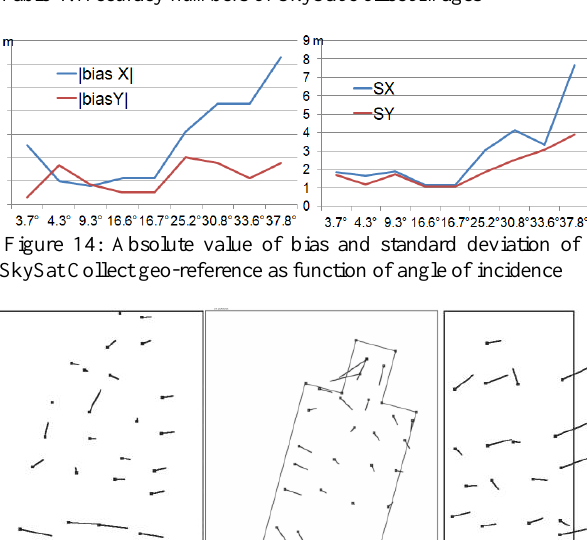
Table 4: Accuracy numbers of SkySat Collect images